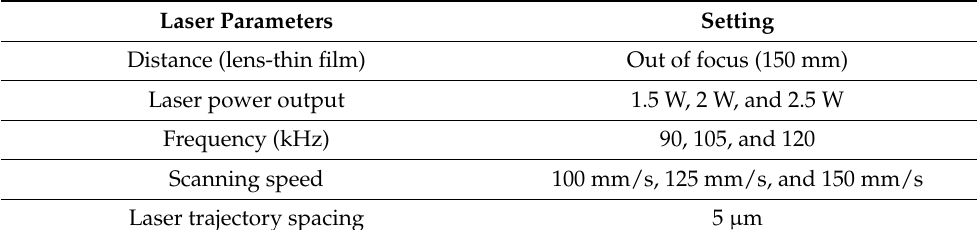
Figure 4. ( a ) Microscope photography of 1 W sintered thin film with 100 mm/s laser scanning speed (scale bar 50 μ m). ( b ) microscope photography of 3 W sintered thin film with 100 mm/s laser scanning speed (scale bar 50 μ m). Table 2. Laser parameters experiments